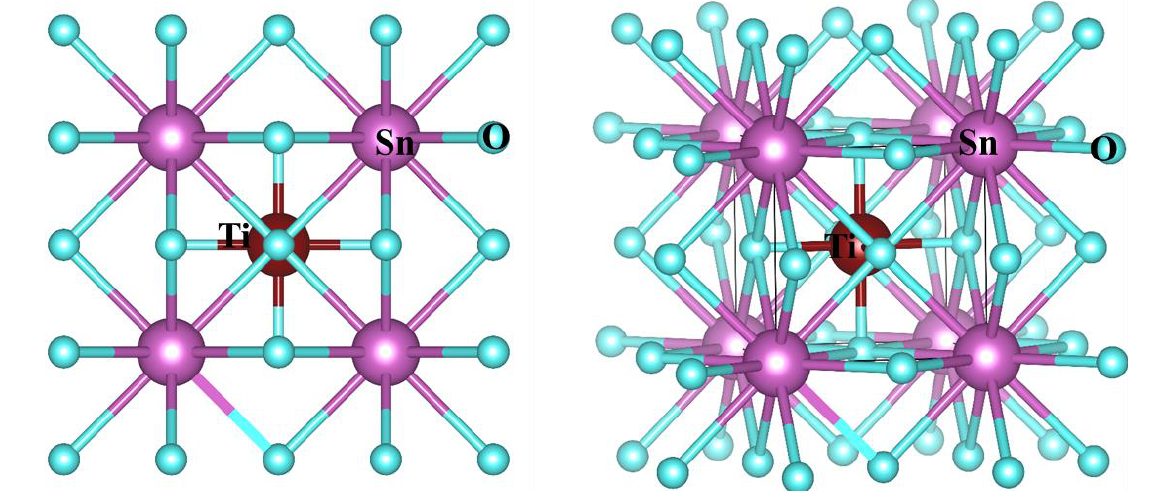
Figure 1. Crystal structure of cubic SnTiO 3 . Table 1. Estimated lattice parameter a (Å ), bulk modulus B , bulk modulus derivative B P , the mini-